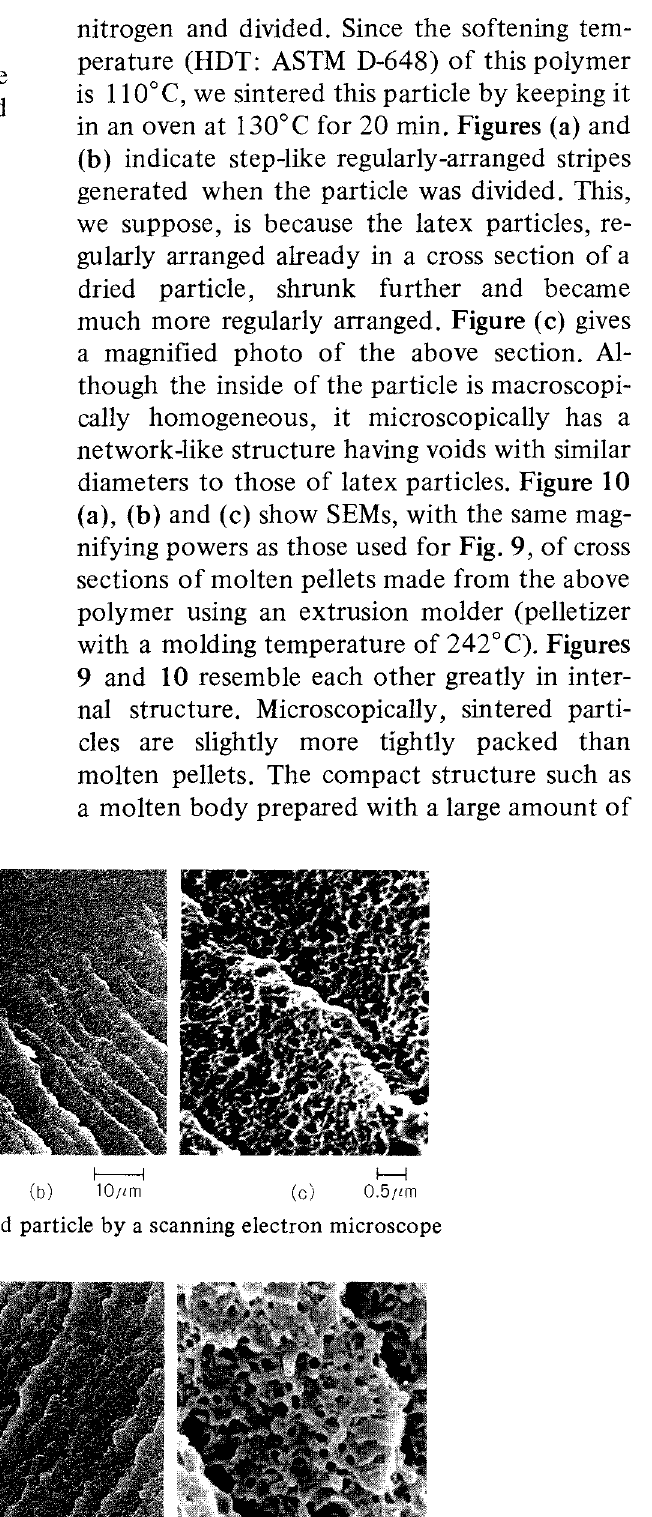
Fig. 9 Photographs of inside sintered particle by a scanning electron microscope